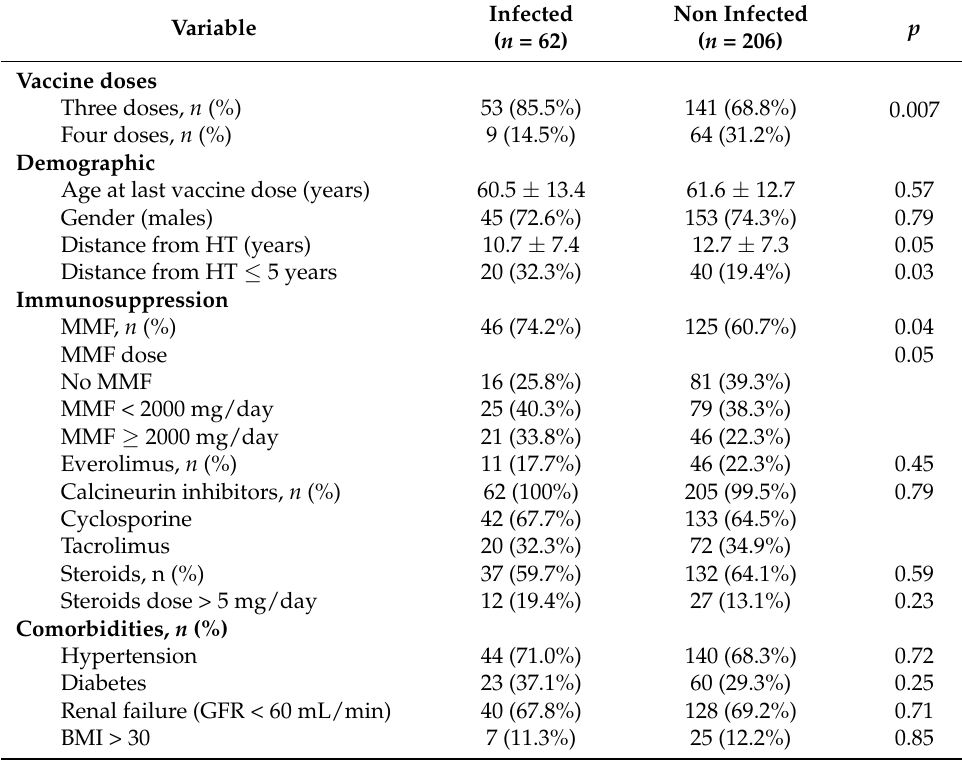
Table 3. Different characteristics of the study population according to known SARS-CoV-2